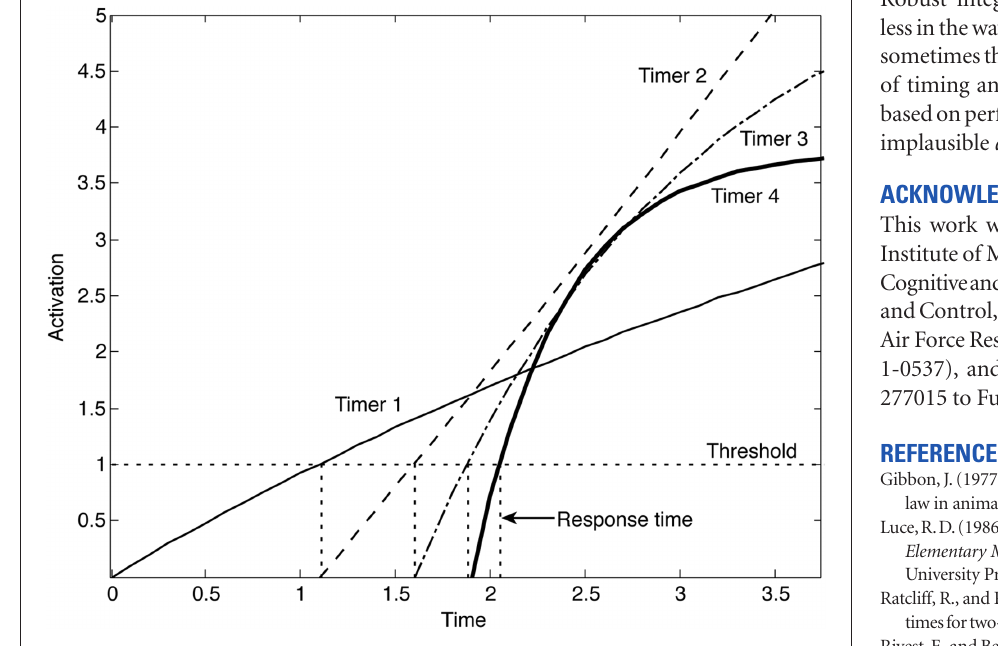
FIgure 1 | Activation time histories for four sequentially triggered interval timers, based on imperfectly balanced integrators (for each timer, k is selected from a normal distribution with mean and SD of 0.1). Here t